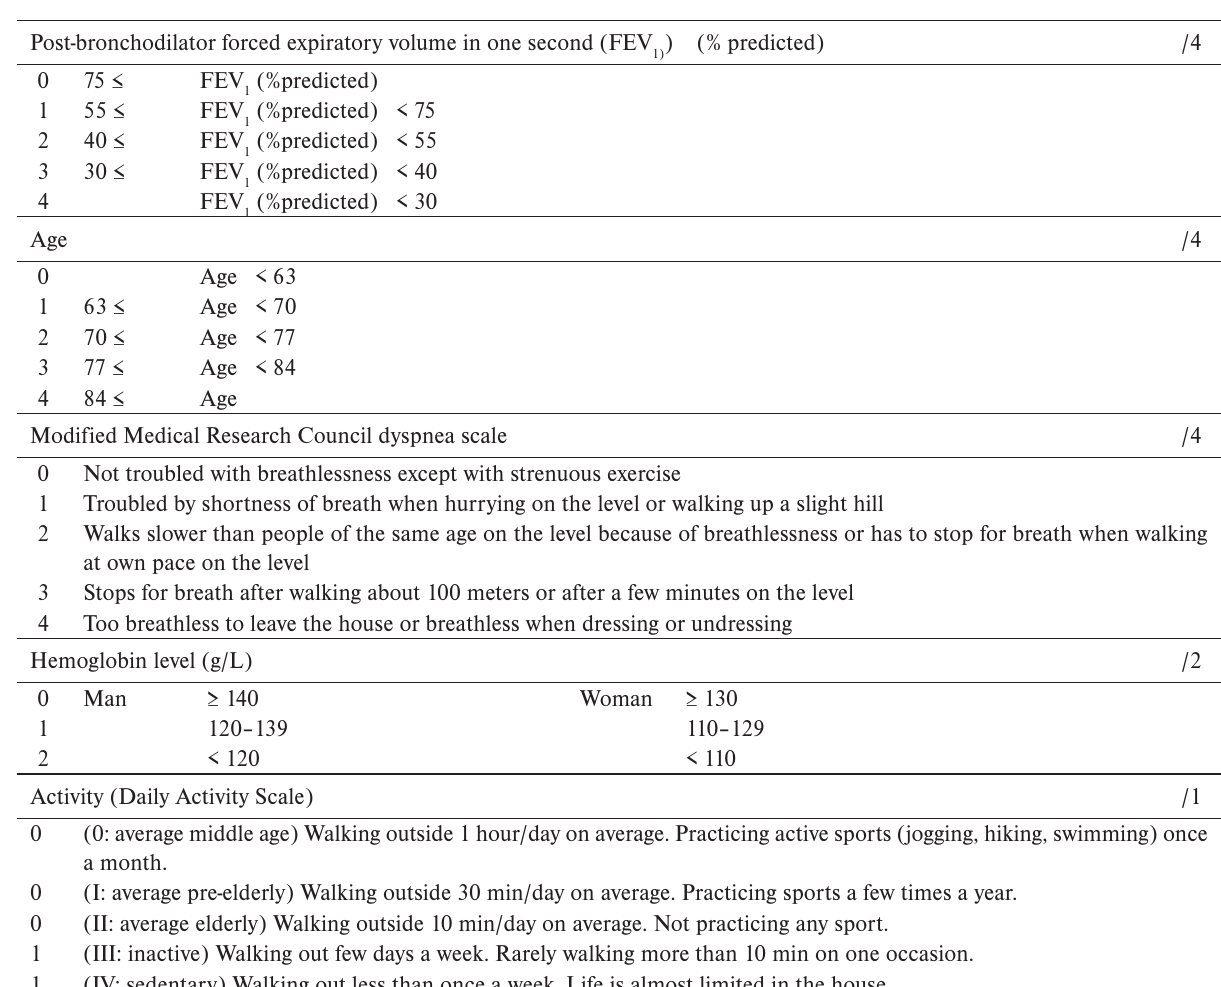
Table 2. The COPD Prognostic